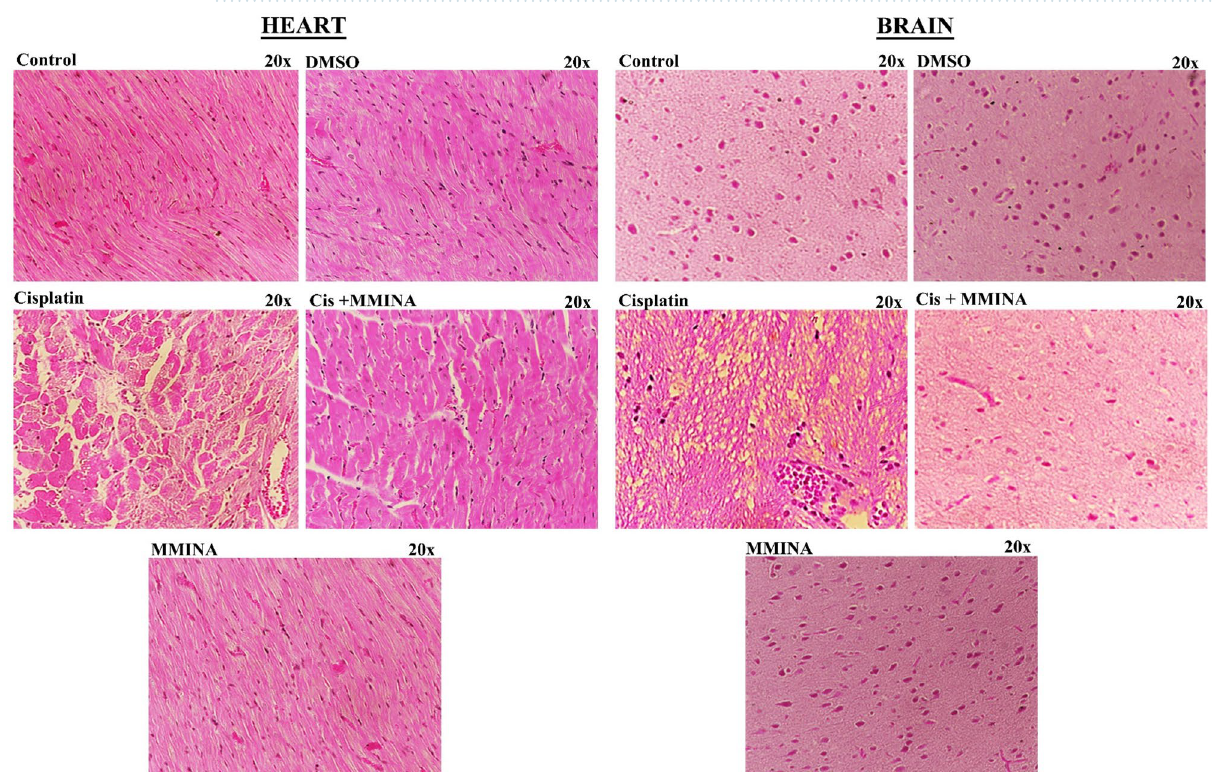
Figure 7. H & E staining of Heart and Brain tissues from various treatment groups at